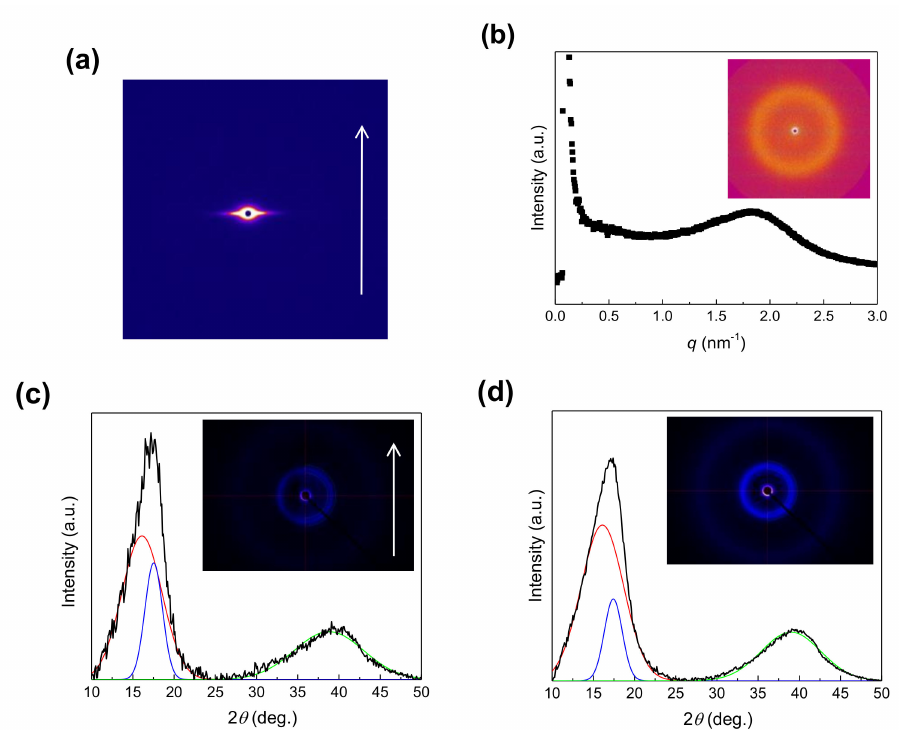
Figure 7. SAXS and WAXD results of Nafion/PEO (99:1) composite samples. ( a ) Two-dimensional (2D) SAXS pattern of the aligned NFs and ( b ) SAXS profile of the film. (Inset) 2D SAXS pattern. De-convoluted WAXD profiles of the ( c ) aligned NFs and ( d ) film. (Insets) 2D WAXD patterns. The white arrows in ( a , c ) show the fiber axis direction. Table 2. Degree of crystallinity and apparent crystallite size of the aligned NFs and Nafion/PEO (99:1) composite samples.